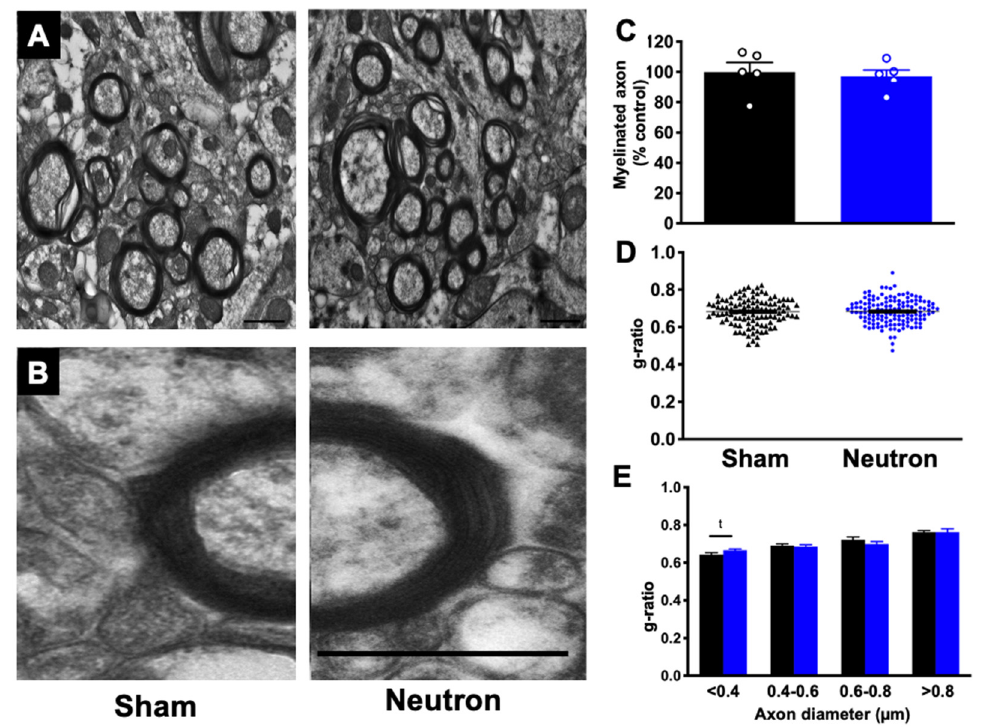
Figure 5. Chronic low dose neutron irradiation does not affect myelination. ( A ) Representative myelin images from sham and neutron treated mice. Scale bar = 800 nm. ( B ) Electron micrograph depicting a single axon of similar diameter in sham mice ( left ) and neutron irradiated mice ( right ). Scale bar = 400 nm. ( C ) There was no significant difference in the percentage of myelinated axons between neutron irradiated mice and sham. Data represents group means ± SEM. There is no difference in overall g-ratios in neutron irradiated mice compared to shams ( D ) and when binned according to axon diameter ( E ). There was an increase in g-ratio in axons with diameters < 0.4 um in irradiated mice, but it did not reach significance. Unpaired t-test; p = 0.058. Data represents individual measurements ± SEM.